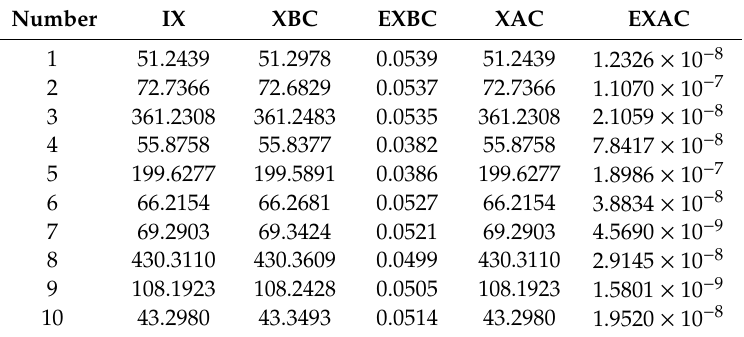
Table 2. The systematic error before and after compensation of the simulated star image with σ PSF = 0.3.